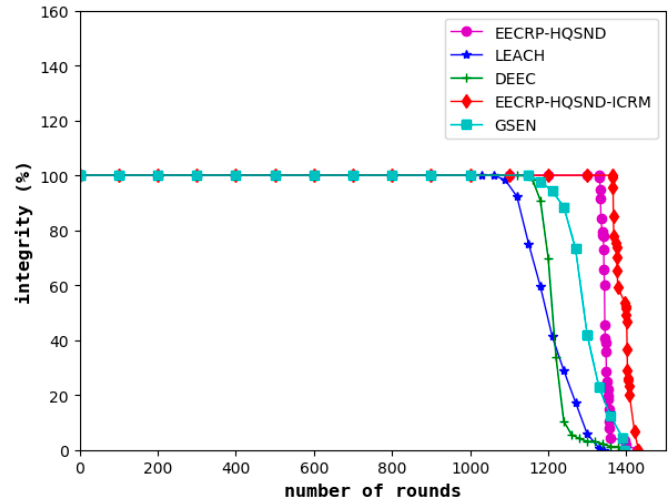
Figure 17. The information integrity varies with the iteration round.